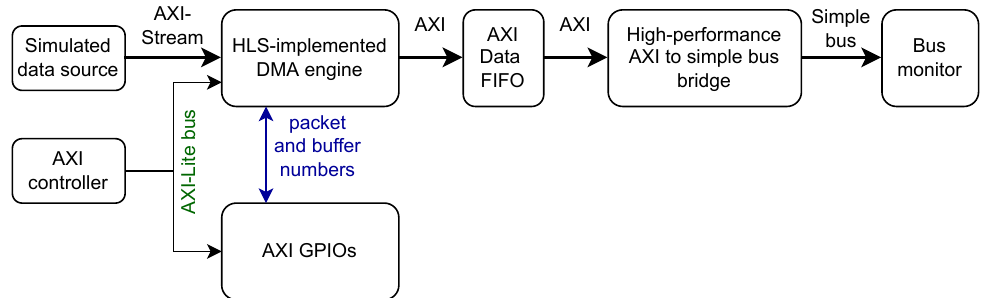
Figure 9. The test environment used for simulation. The AXI controller initializes the DMA engine. The high-performance AXI to simple bus bridge was implemented based on the “demofull” core from [23]. The simulated environment is available in the git repository [39] in the test_env